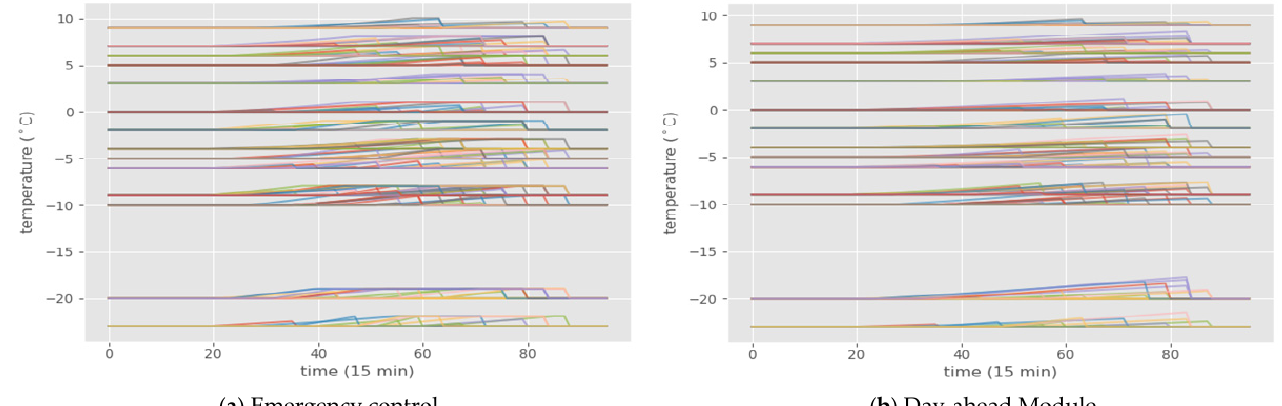
Figure 5. Temperature change of containers.